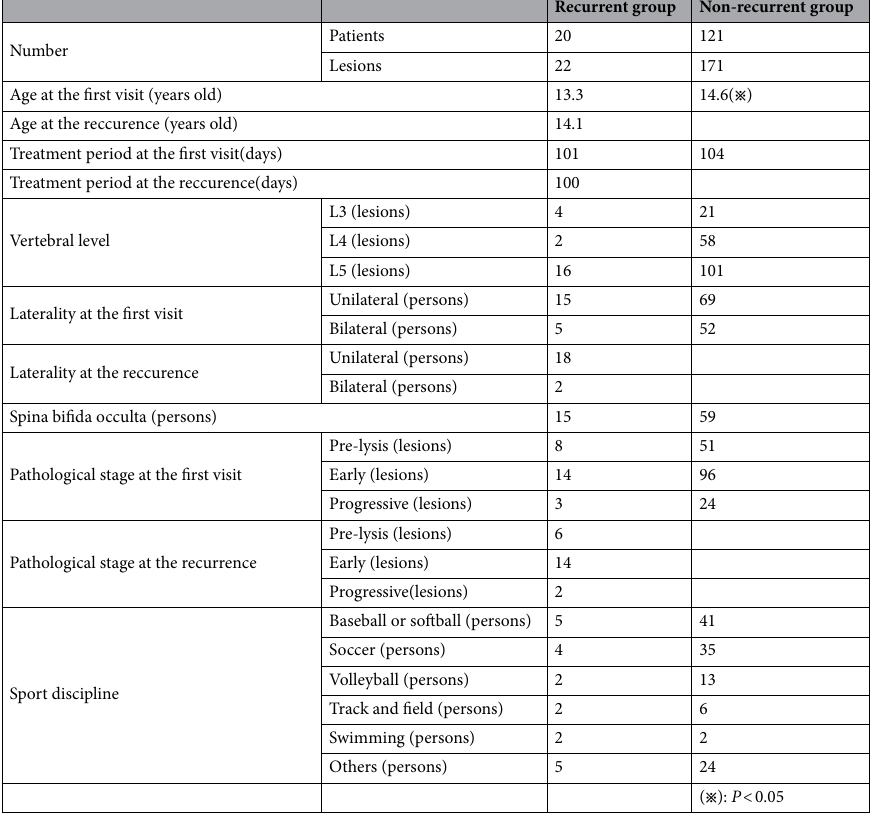
Table 1. Patient demographics. The number, age, treatment period, vertebral level of the lesion, laterality, spina bifida occulta, pathological stage, and sport discipline of recurrent group and non- recurrent